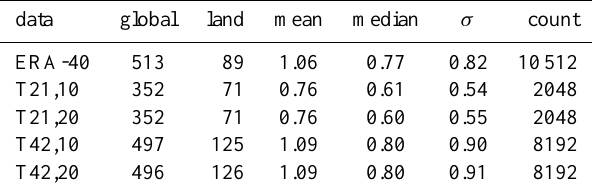
Table 1. Mean data values for ECMWF ERA-40 reanalysis data (1958–2001), T21 spectral resolution with 10 and 20 vertical layers (20 year mean), and T42 spectral resolution and 10 vertical layers and 20 vertical (20 year mean) is shown. The corresponding units are: global=global atmospheric boundary layer dissipation in ter- awatts (TW), land=non-glaciated land atmospheric boundary layer dissipation in terawatts (TW), mean=mean of all data values in Wm − 2 , median = median of all data values in Wm 2 , σ =standard deviation of all data values, and count=number of input data val- ues.